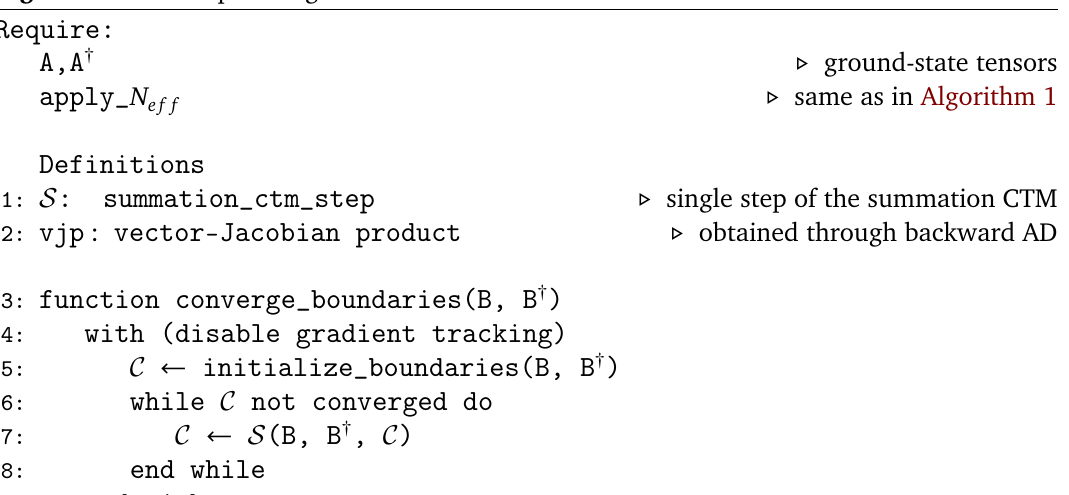
Algorithm 2 Fixed-point